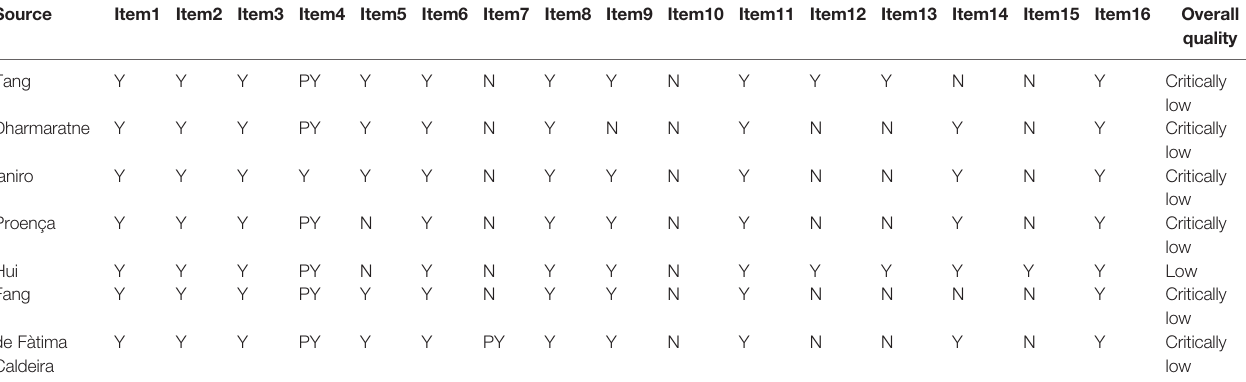
TABLE 2 | The methodological quality of included meta-analysis using AMSTAR-2.